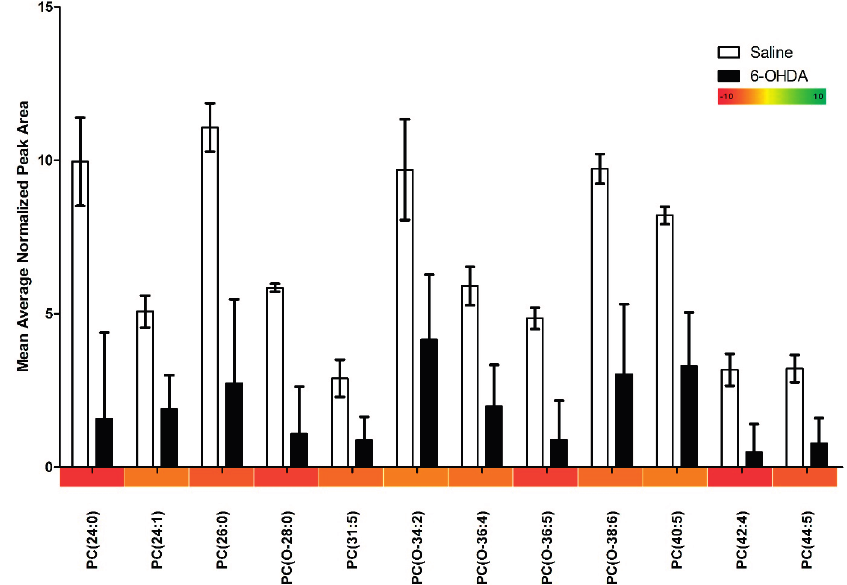
Figure 1. The relative abundance of phosphatidylcholine species in the substantia nigra of animals treated with either 6-OHDA (20 µg) or saline vehicle into the right anterior dorsal striatum, as determined by HPLC-ESI-MS/MS measurements. All measurements were run in triplicate and the error bars represent the standard error. Only species displaying significant differences between treatment and control groups are shown. Significance was determined by independent sample t -test. The relative fold change of phosphatidylcholine species is represented along the X-axis in the form of a color heat map.